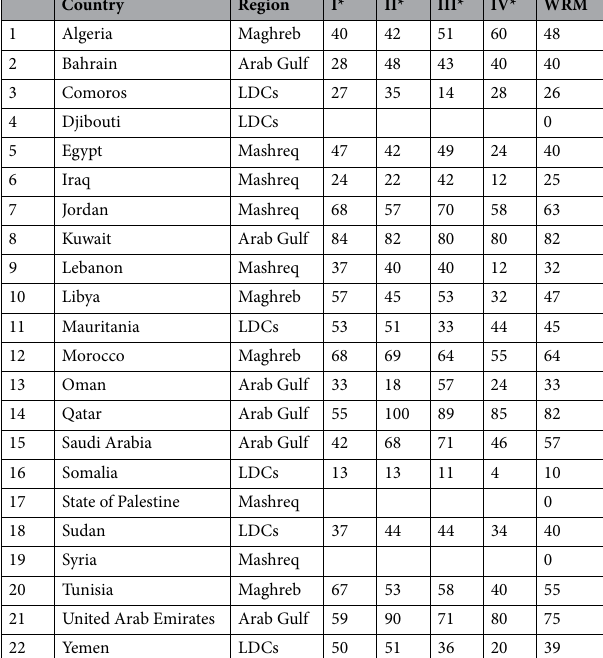
Table 1. Degree of IWRM achievement in the Arabsphere